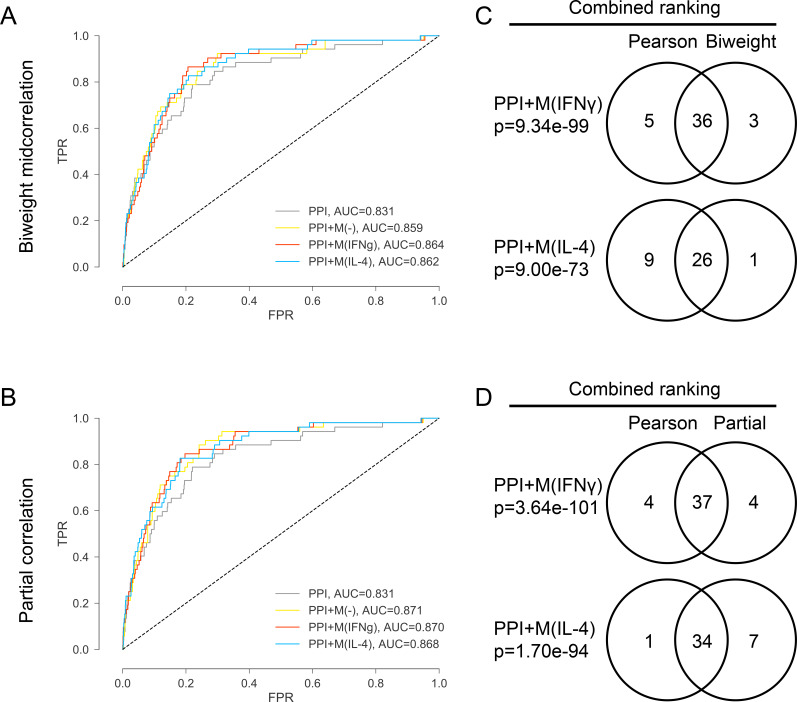
(A) ROC curves for PPI, PPI + M(-), PPI + M(IFNγ) and PPI + M(IL-4) where the co-abundance networks M(-), M(IFNγ) and M(IL-4) were built using biweight midcorrelation as the correlation measure. (B) ROC curves for PPI, PPI + M(-), PPI + M(IFNγ) and PPI + M(IL-4) where the co-abundance networks M(-), M(IFNγ) and M(IL-4) were built using partial correlation as the correlation measure, controlling for baseline abundances M(-). (C) Venn diagrams showing the overlap in terms of the final combined ranking between the two cases where Pearson’s correlation and biweight midcorrelation were used to build the co-abundance networks. Results are shown for the non-optimized case. Fisher’s exact test was used and two-sided p-values were reported. (D) Venn diagrams showing the overlap in terms of the final combined ranking between the two cases where Pearson’s correlation and partial correlation were used to build the co-abundance networks. Results are shown for the non-optimized case. Fisher’s exact test was used and two-sided p-values were reported.